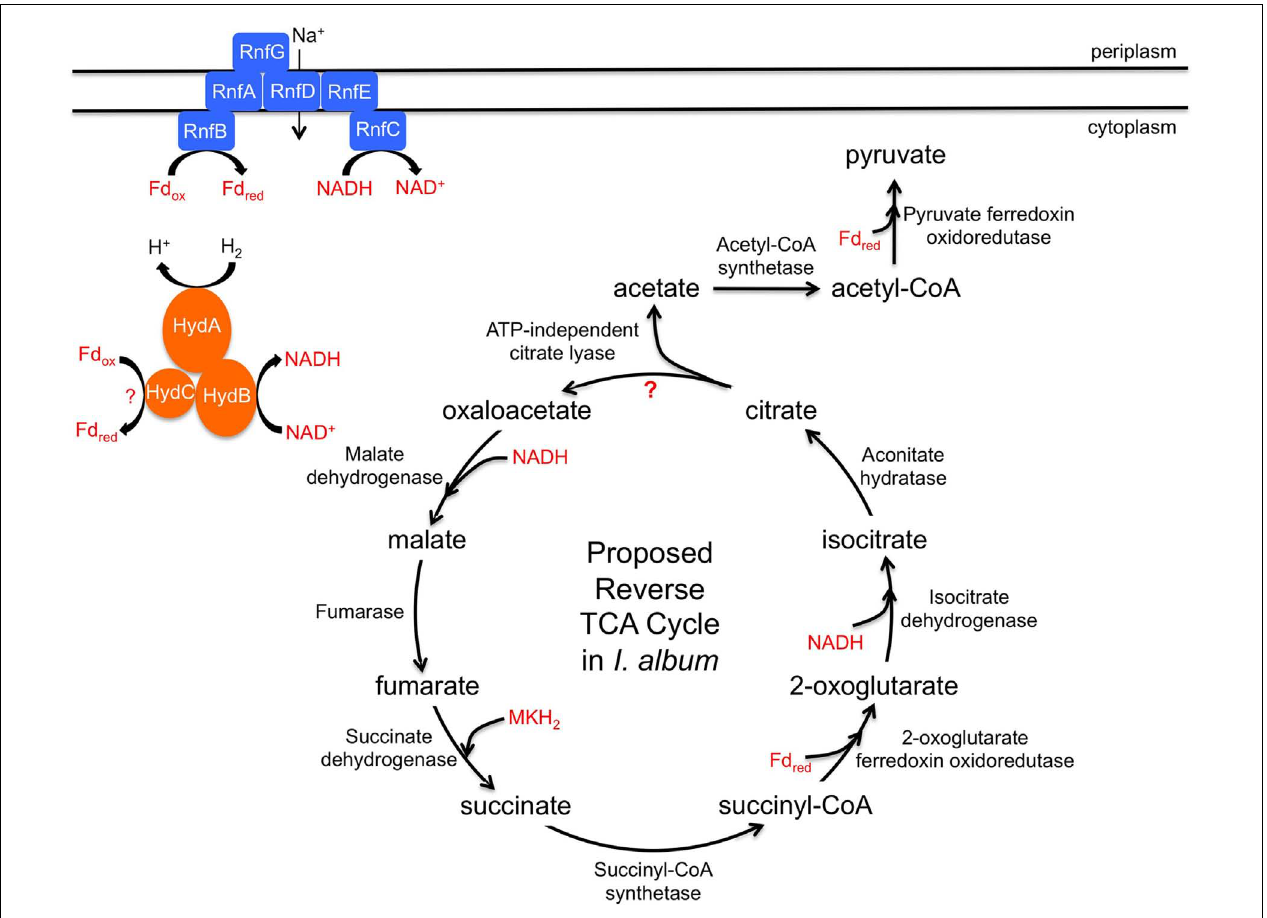
FIGURE 4 | Proposed mixotrophy and a potential unconventional reverseTCA cycle in I. album . Fd, ferredoxin; red, reduced; ox, oxidized; Hyd, hydrogenase; MKH 2 , menaquinol; Rnf, Na + -translocating ferredoxin:NAD +